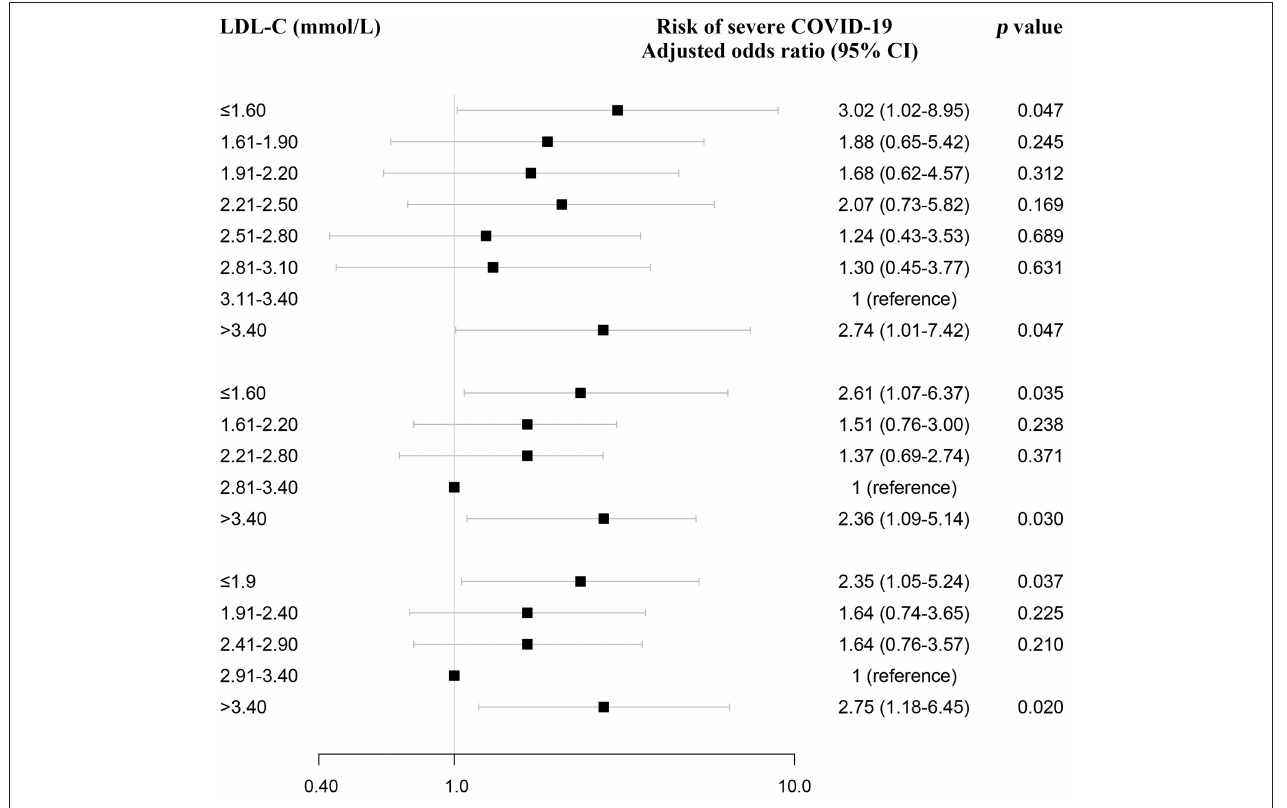
FIGURE 4 | Association between LDL-C and severe COVID-19 using multivariate logistic regression analysis and sensitivity analysis. LDL-C and risk of severe COVID-19 using multivariate logistic regression analysis. After adjusting for age, gender, CRP, LDH, and NLR, odds ratios were from multivariate logistic regression analysis. CRP, C-reactive protein; LDH, lactate dehydrogenase; NLR, neutrophil-to-lymphocyte